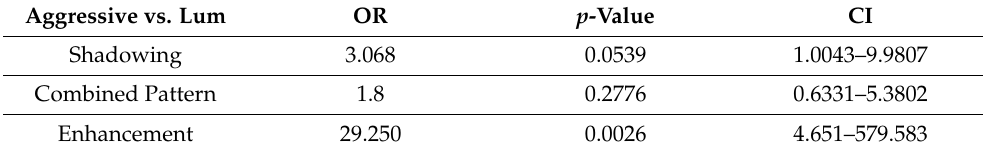
Table 7. Effect of a variable “posterior features” in aggressive vs. luminal subtypes. Aggressive vs.